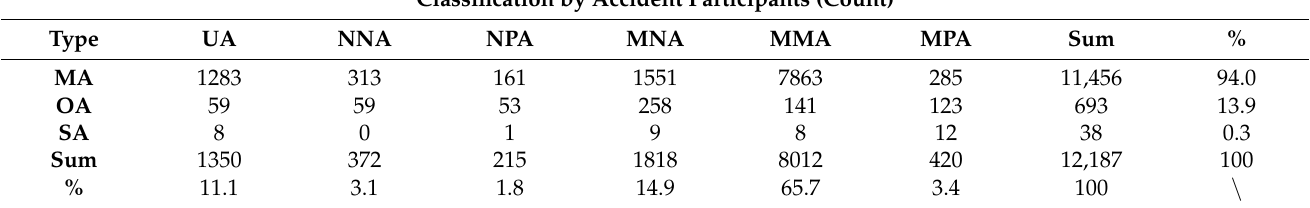
Table 1. A summary of the crash dataset. Classification by Accident Participants